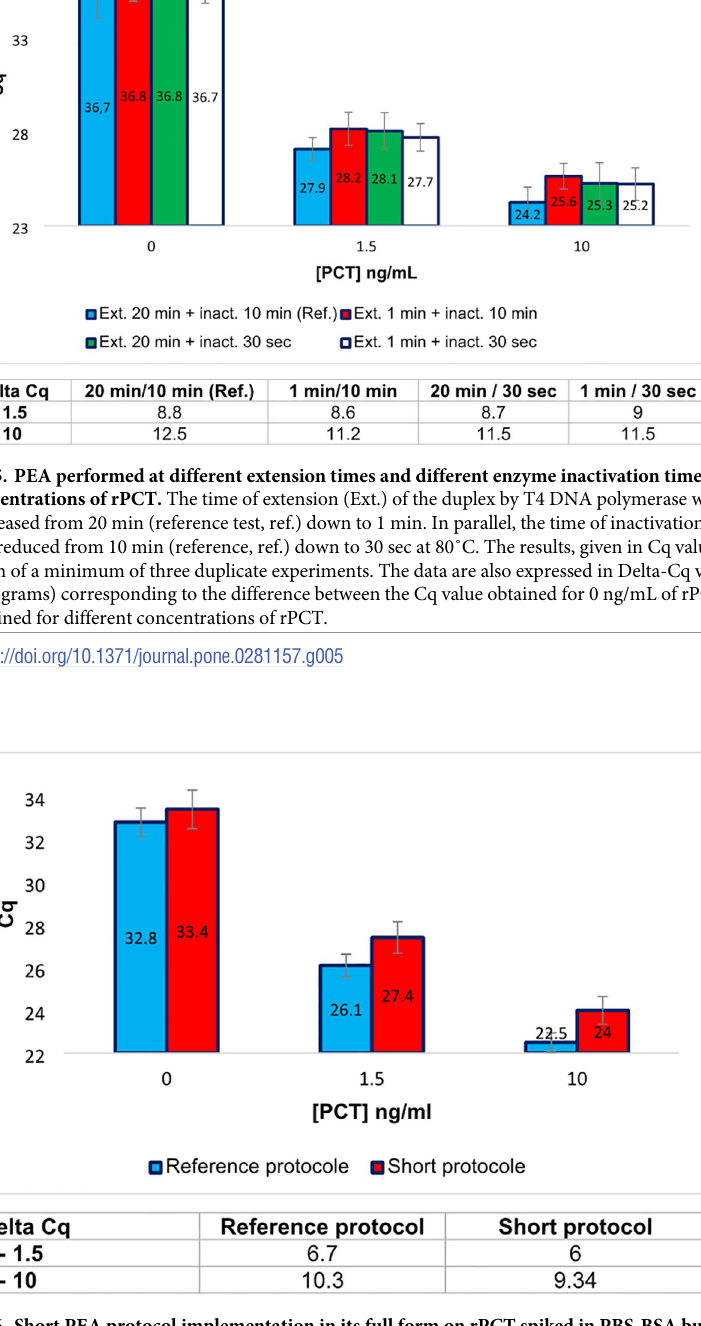
Fig 6. Short PEA protocol implementation in its full form on rPCT spiked in PBS-BSA buffer. The short protocol was compared in terms of Cq values with the reference protocol, on three rPCT concentrations. The results, given in Cq, correspond to the mean of a minimum of three duplicate experiments. The data are also expressed in Delta-Cq (Table below the histograms) corresponding to the difference between the Cq value obtained for 0 ng/mL of rPCT and the Cq value obtained for different concentrations of rPCT.